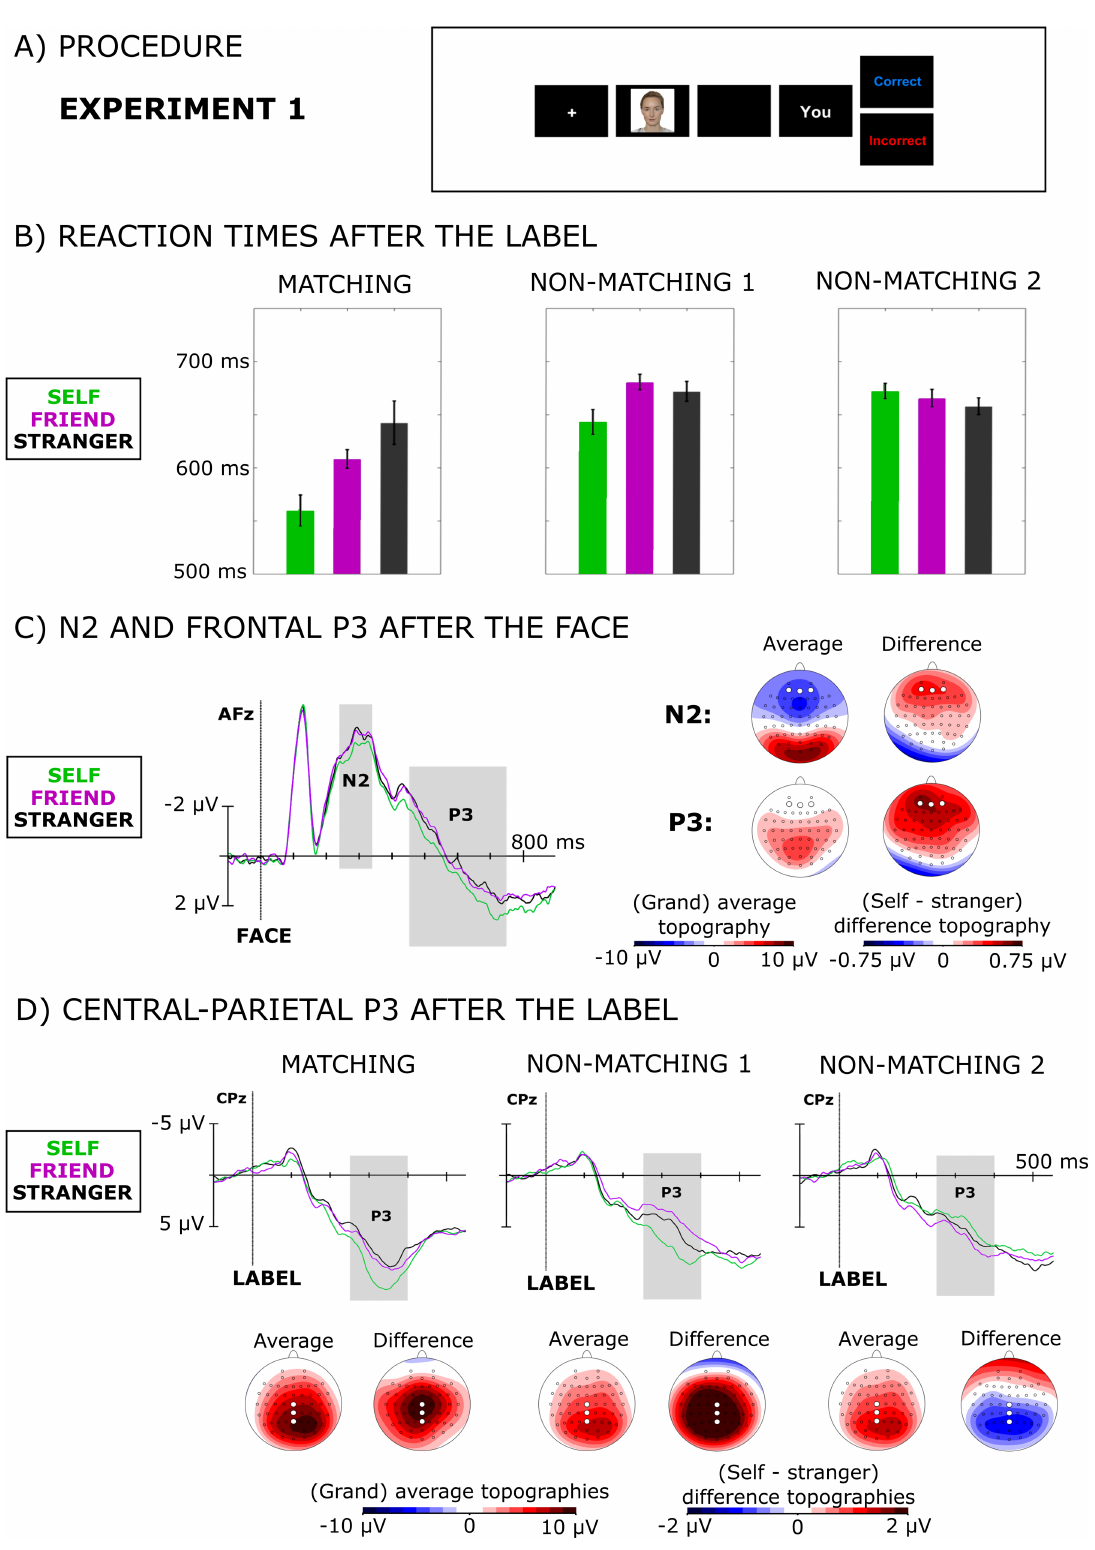
Fig 3. The results of experiment 1. (A) A single trial from experiment 1 illustratingthe procedure. (B) Reactiontimes separately for (from left to right) matching, non-matching 1 (NM1), and non-matching 2 (NM2) trials (see Fig 2 for explanation